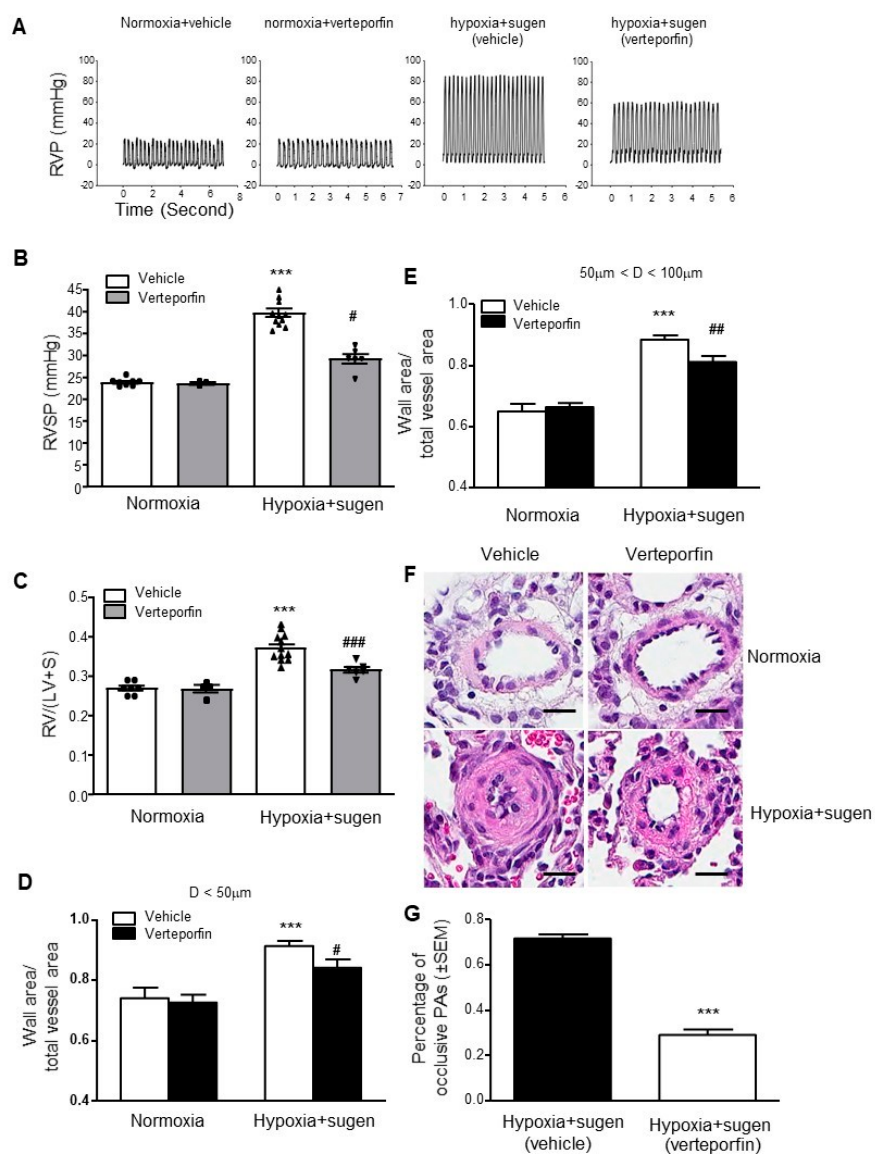
Figure 11. YAP inhibition with verteporfin attenuates hypoxia-plus-Sugen-mediated pulmonary hypertension in rats. Compared with the controls, verteporfin treatment attenuated the develop- ment of pulmonary artery hypertension (PAH), as assessed by changes in right ventricular systolic pressure (RVSP), right ventricular hypertrophy (RV/LV+S), and the development of medial hyper- trophy and neointima formation. ( A ) Representative record of right ventricular pressure (RVP) trac- ings; ( B ) changes in RVSP; ( C ) changes in RV/(LV + S); ( D ) changes in ratios of wall area to total vessel area of pulmonary arteries less than 50 µm in diameter in the lung sections of the control and